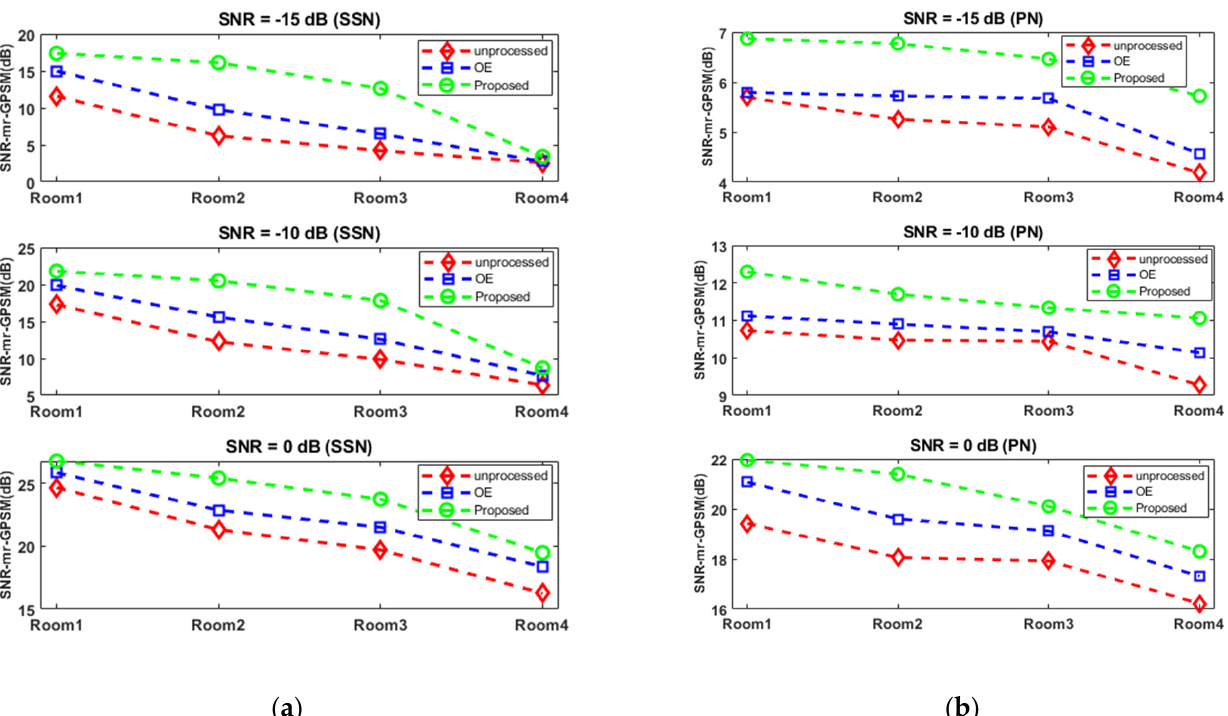
Figure 5. ( a ) The predictions of mr-GPSM in the presence of SSN for three SNR values. The intelligibility scores (SNR-mr- GPSM) show up to 5 dB for OE and up to 15 dB improvement in comparison to the unprocessed signal in low SNR = − 15 dB (first-raw panel). The improvement is seen for other SNRs, specifically in rooms R2 and R3. The model shows lower improvement for preprocessed signals in rooms R1 and R4.; ( b ) The predictions of mr-GPSM in the presence of pink noise (PN) for three SNR values. The intelligibility scores (SNR-mr-GPSM) show less than 1 dB improvement for OE and about 2 dB improvement using the proposed approach.